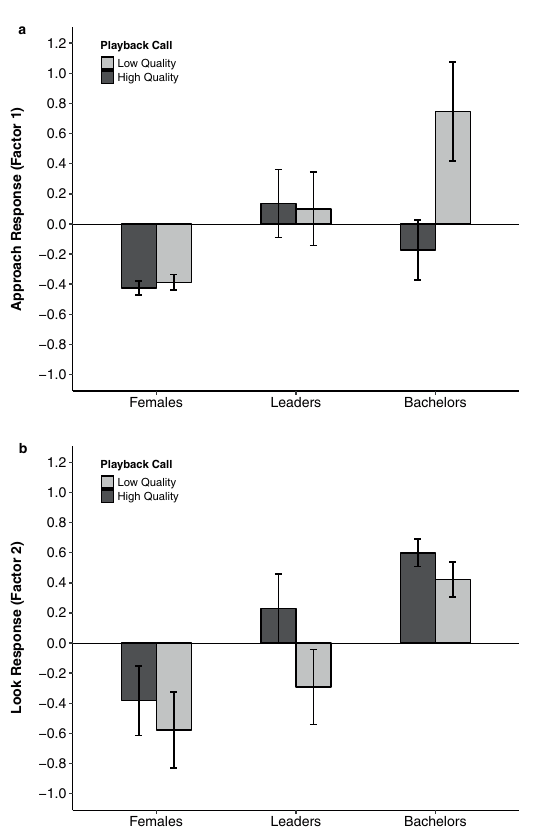
Figure 2. Subject responses (Mean of factor scores + SEM) to simulated high and low quality loud calls from bachelors, leaders, and females. ( a ) Factor 1 is a composite score where larger values indicate a stronger “approach” response. ( b ) Factor 2 is a composite score where larger values indicate a stronger “look” response. See text for